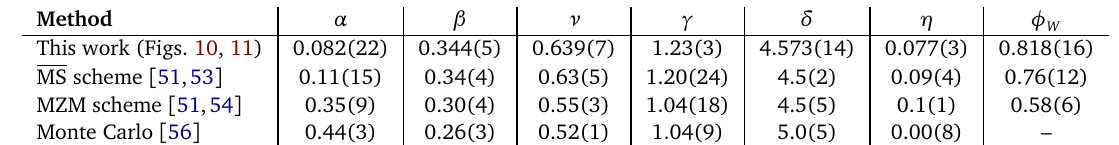
Table 3: O ( 2 ) × O ( 3 ) “chiral” critical exponents.